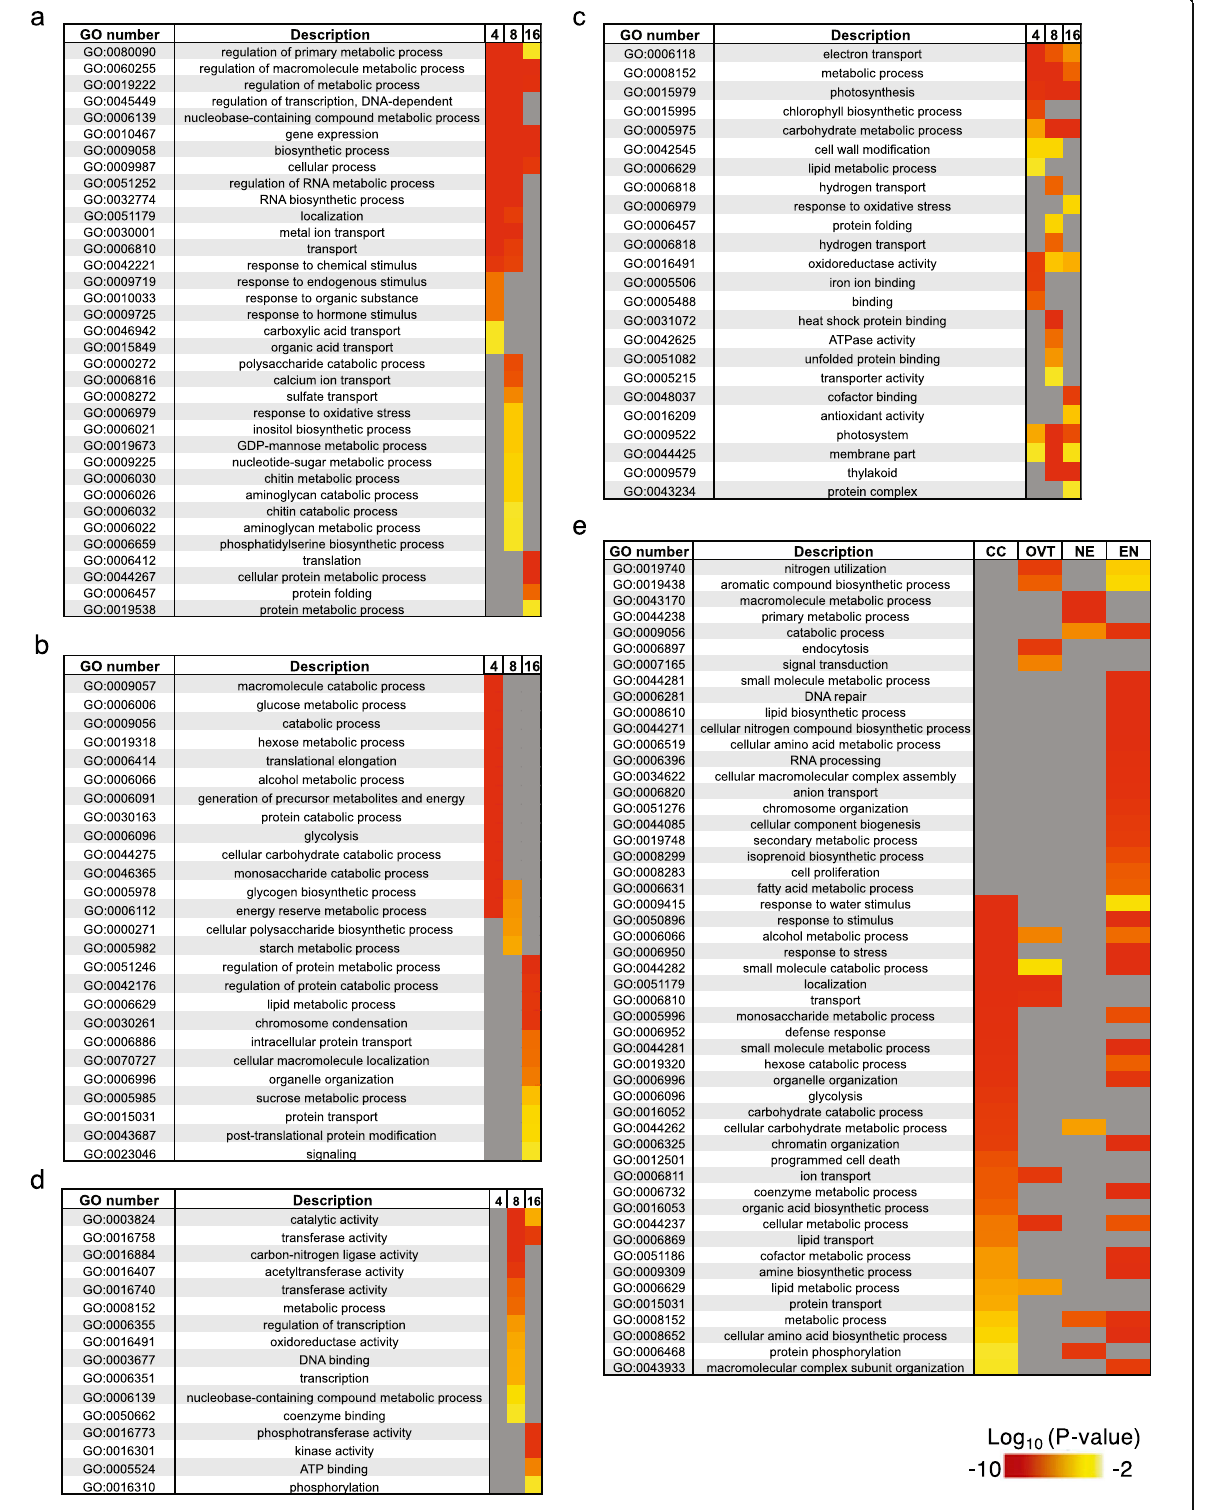
Fig. 2 Gene Ontology (GO) analysis of the DEGs in different tissues of the developing rice grain at 4, 8 and 16 days after flowering (DAF). Significantly ( p < 0.01) overrepresented GO terms in (a) OVT, (b) CC, (c) EN, (d) NE and (e) AL are shown as heatmaps. If a certain GO term was not significantly enriched ( P -value > 0.01) in a certain tissue or stage, the cell is colored